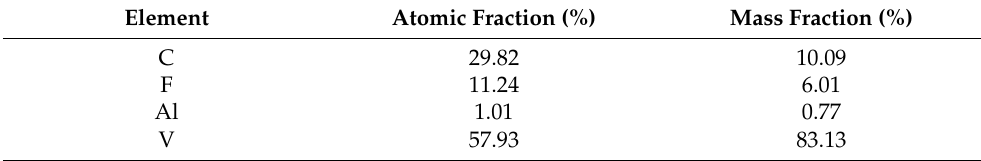
Figure 4. ( a ) HR–TEM and ( b ) TEM images of V 2 C, ( c ) TEM–EDX elemental mapping images of V 2 C. Table 2. The element contents in the material (area